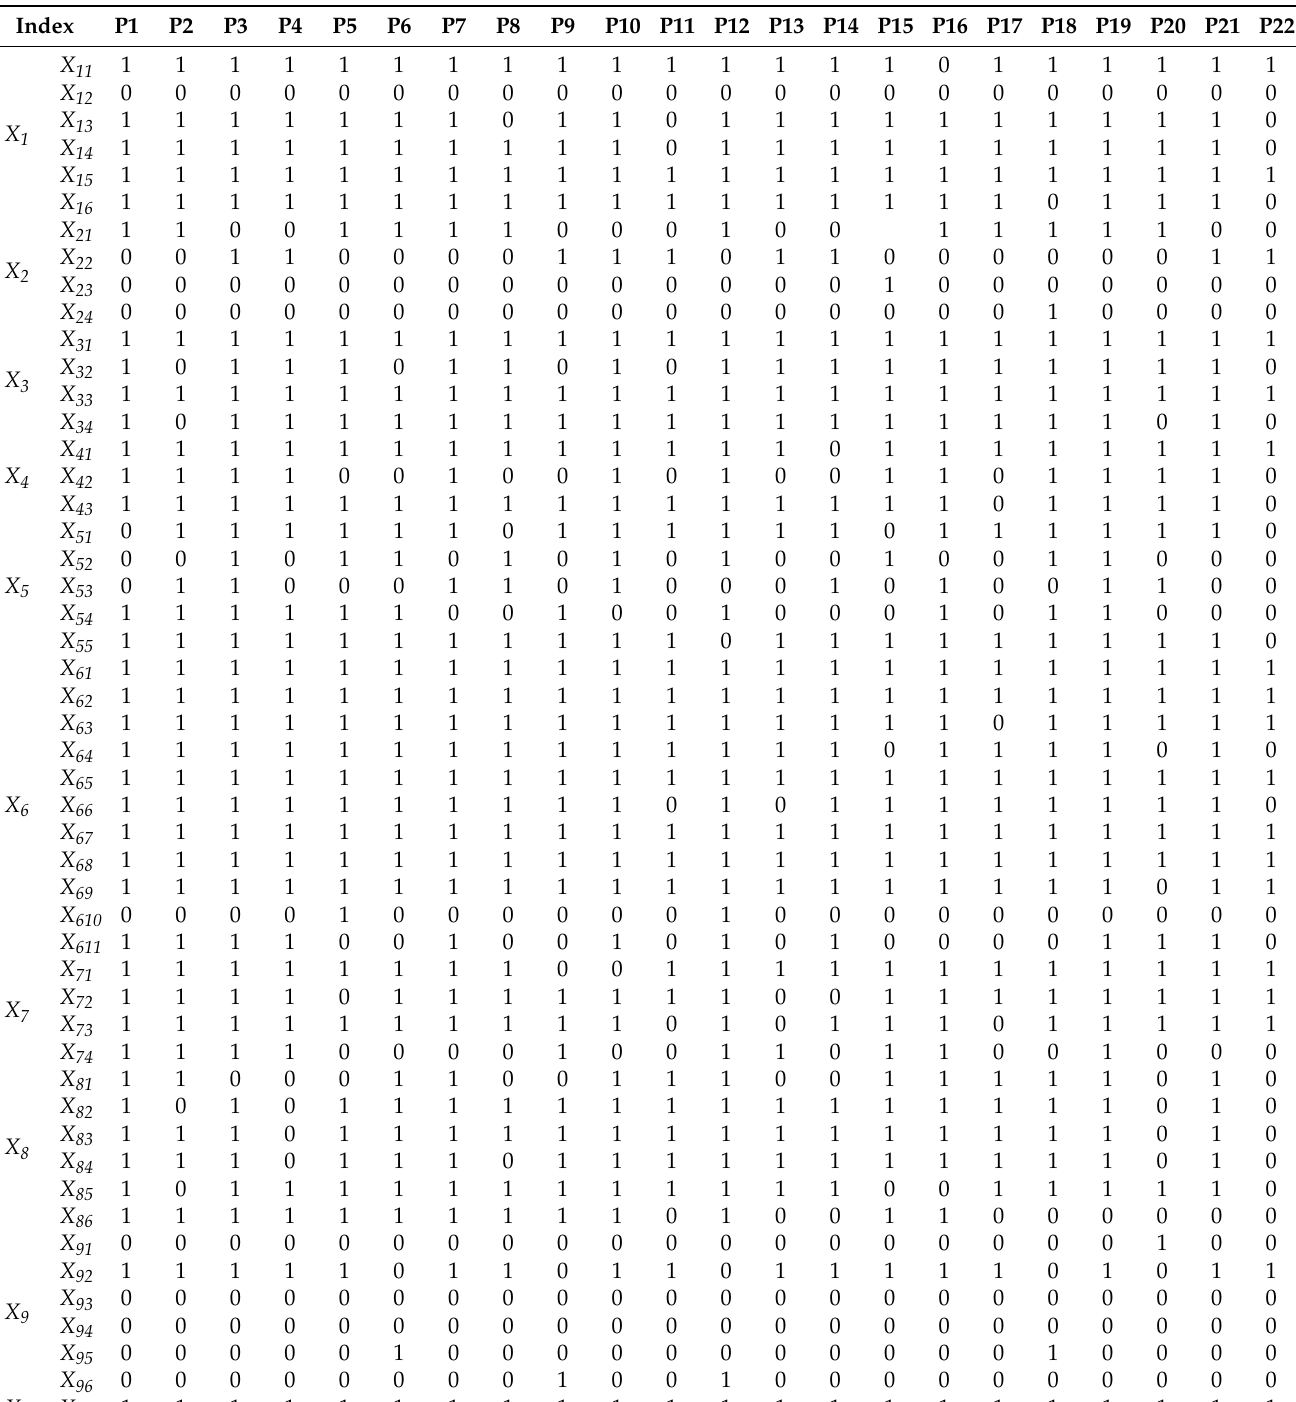
Table 5. The multi-input/output matrix of the 22